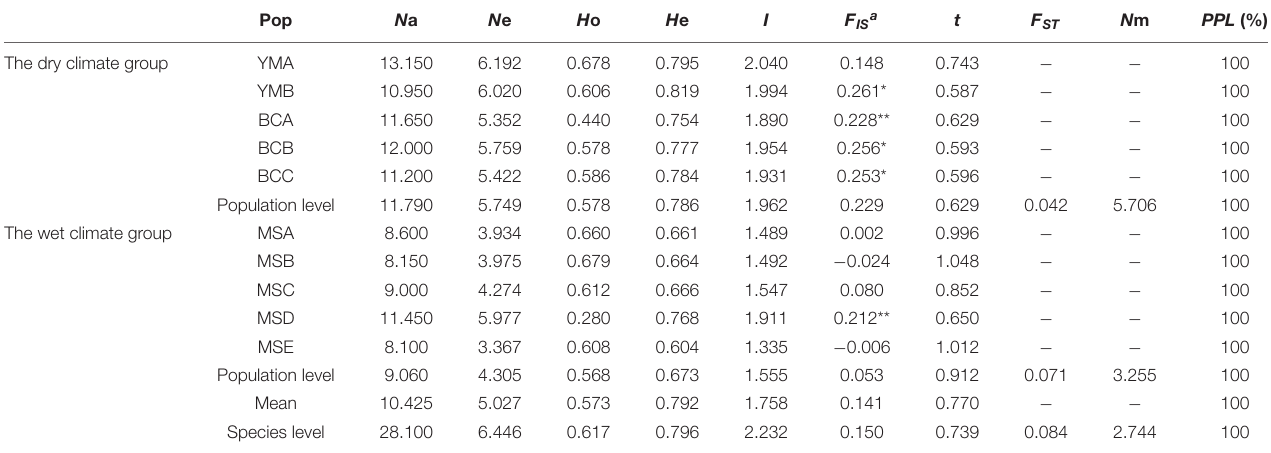
TABLE 2 | Genetic diversity in 10 populations of P. emblica. Pop N a N e H o H e I F ISa